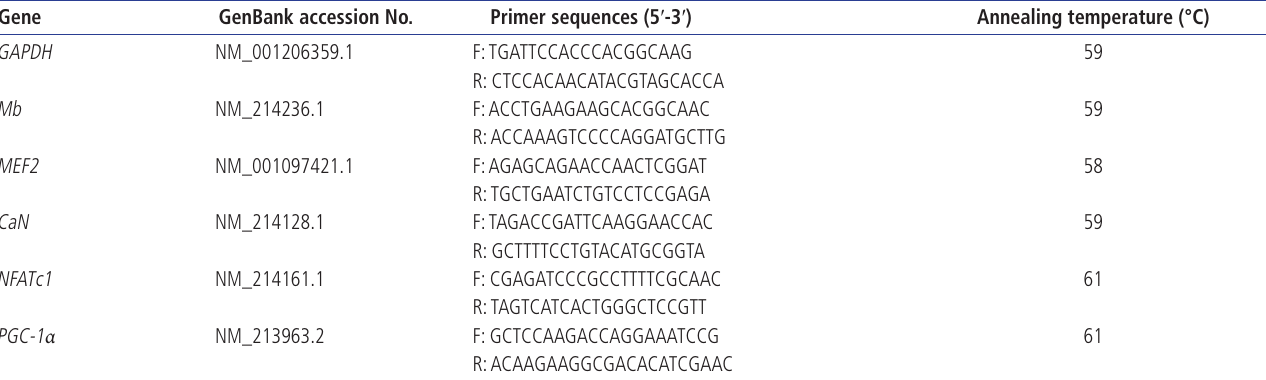
Table 3. Primers for RT-qPCR Gene GenBank accession No.